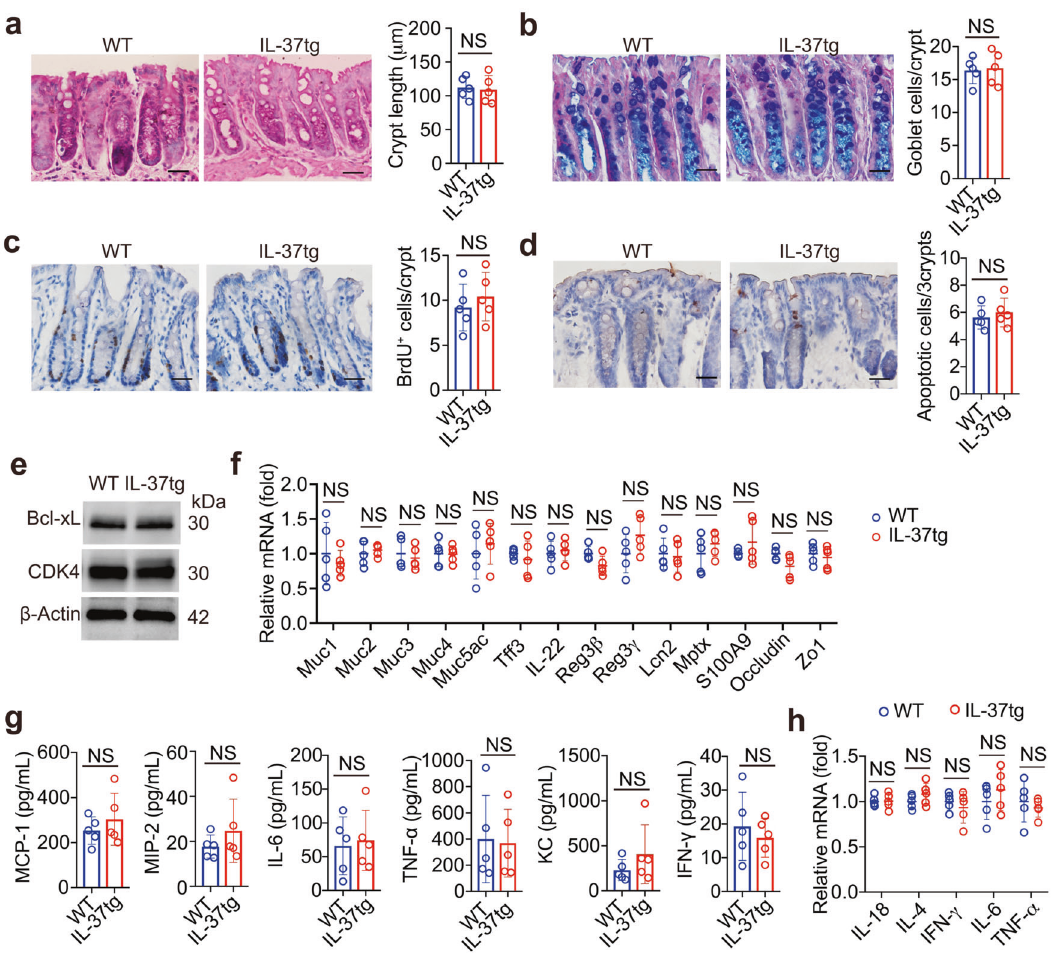
Fig. 1 The colon epithelium of IL-37-transgenic mice exhibits balanced homeostasis. a Representative H&E-stained sections (left, scale bar: 50 μ m) of the distal colon of IL-37tg mice and WT mice, and quanti fi cation of the crypt length (right) is shown. At least 15 well-oriented crypts were measured on slides from each mouse, n = 5/group. b Representative alcian blue and PAS staining of distal colon sections obtained from IL-37tg mice and WT mice (left, scale bar: 50 μ m). Statistical analysis of enumeration of goblet cells per crypt (right), at least 15 well-oriented crypts were measured on slides from each mouse, n = 5/group. c 50 mg/kg BrdU was administrated to IL-37tg mice and WT mice by intraperitoneal injection. The colon sections were harvested and stained for BrdU-positive cells at 24 h after BrdU injection. Representative BrdU-stained sections are shown (left, scale bar: 50 μ m). Statistical analysis of BrdU-positive cells per crypt (right), at least 15 well-oriented crypts were counted on slides from each mouse, n = 5/group. d DNA fragmentation in the colon of IL-37tg mice and WT mice was detected by in situ TUNEL assay. Apoptotic cells were stained brown and nuclei were stained blue by hemotoxylin, at least 15 Well-oriented crypts were counted on slides from each mouse, scale bar: 50 μ m, n = 5/group. e Immunoblotting was performed to detect CDK4 and Bcl-xL in colon epithelial cells from IL-37tg and WT mice. β -Actin was used as a loading control. f qRT-PCR analysis of indicated genes from the colons of IL- 37tg mice and WT mice, n = 5/group. g The same amount of colon tissue from IL-37tg mice and WT mice was cut into small pieces and incubated in serum-free RPMI medium for 24 h. Secreted chemokines and cytokines in the medium were measured by ELISA assay, n = 5/ group. h qRT-PCR analysis was performed for each indicated gene in colon tissues of IL-37tg mice and WT mice. n = 5/group. All data are presented as mean ± SD. Statistics analyzed by Two-tailed Student ’ s T -test. NS, not signi fi permeability by the FITC-dextran measurement, showing that plasma FITC fl uorescence was signi fi cant increased in IL-37tg mice compared to WT mice (Supplementary Fig. S2k). In conclusion, IL- 37 is disadvantage to maintain colonic tissue repair in IL-37tg mice after treated with DSS.